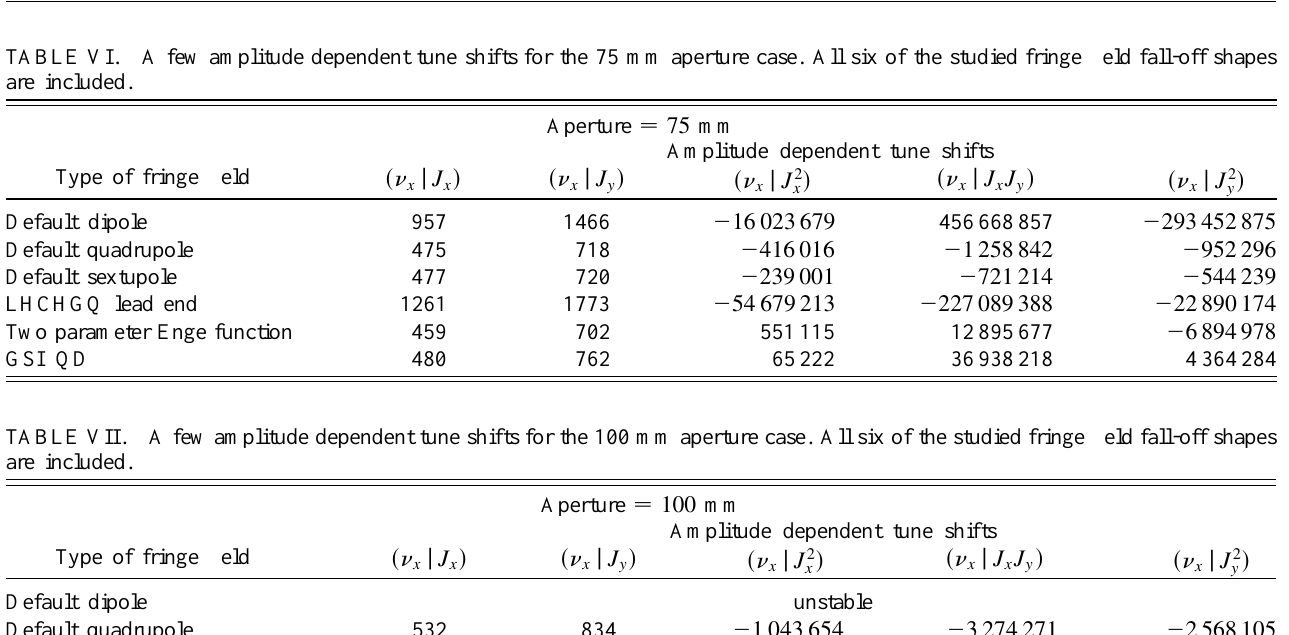
Type of fringe field